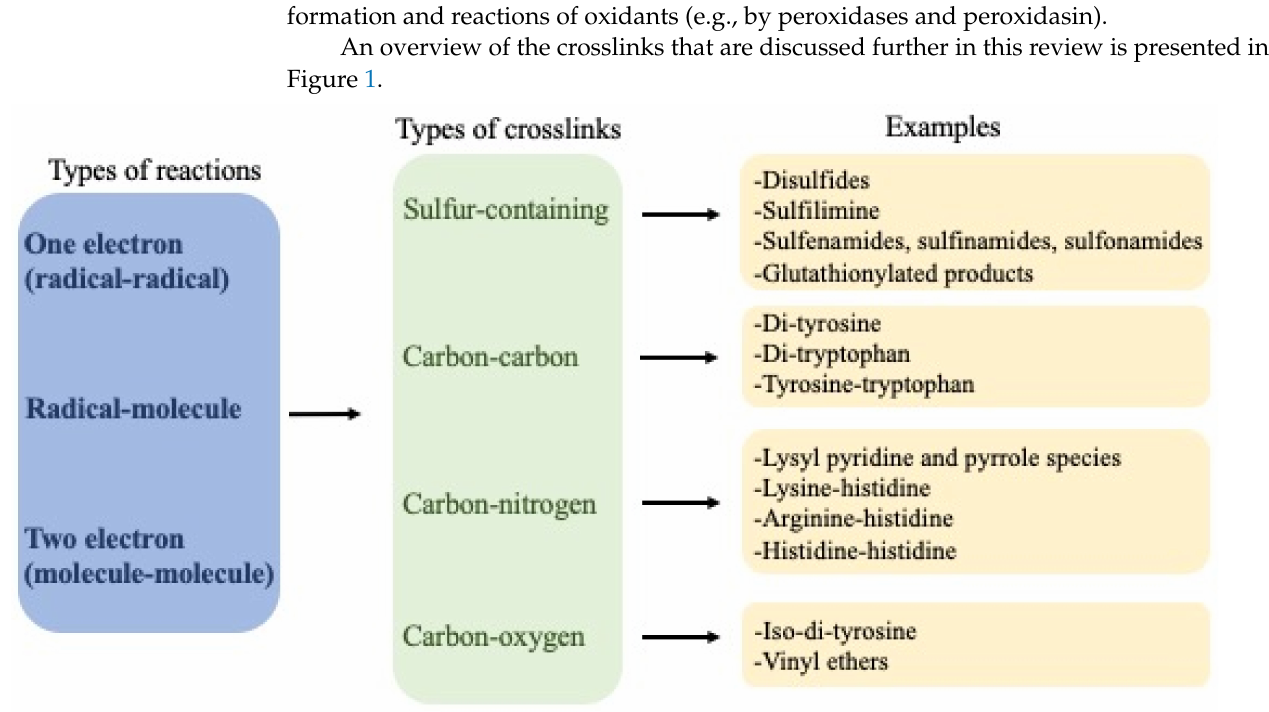
Figure 1. Overview of crosslinks formed on proteins, their nature and mechanisms of